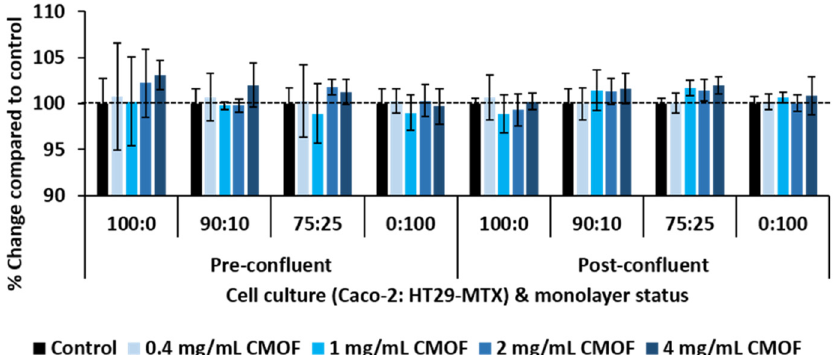
Figure 1. Effect of incubation of a caprine milk oligosaccharide-enriched fraction (CMOF) on the metabolic activity of mono- and co-cultures of Caco-2 and HT29-MTX cells. The metabolic activity of pre-confluent (48 h post-seeding) and post-confluent (day 21 post-seeding) Caco-2:HT29-MTX cell cultures after 24 h incubation as a percentage of control as measured after the Wst-1 assay. Values are means (±SEM) for three experiments (10 samples per treatment per experiment).